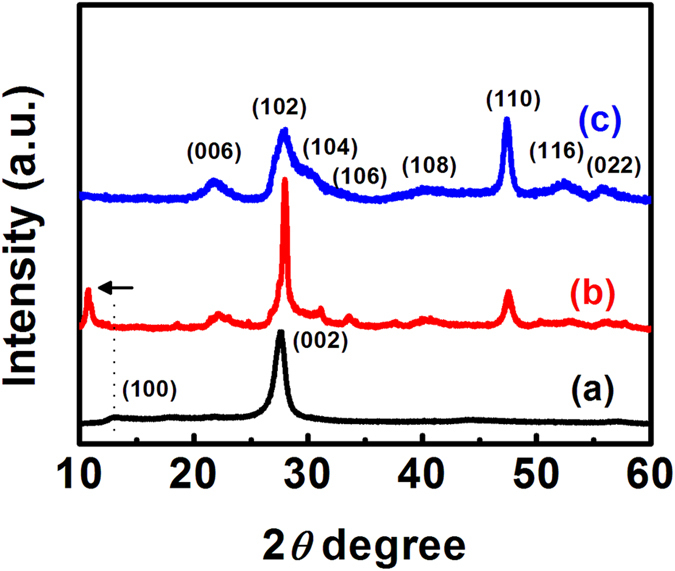
XRD patterns of the as-synthesized samples: (a) g-C3N4 nanosheets; (b) 15 wt% ZnIn2S4/g-C3N4 heterojunction nanosheets; (c) ZnIn2S4 nanosheets.